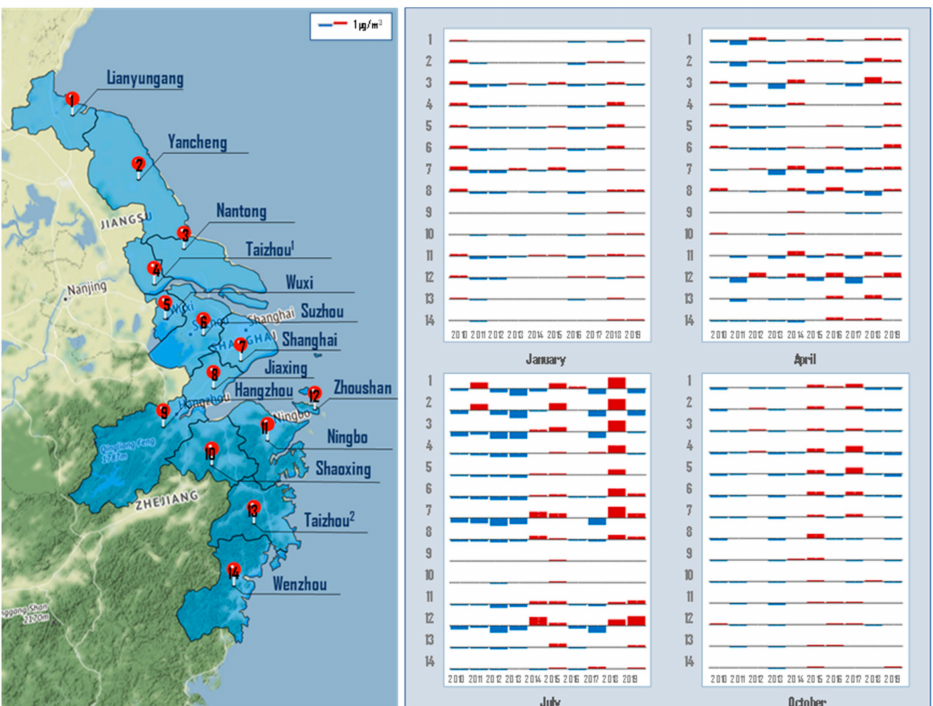
Figure 6. Anomalies of ship-contributed PM 2.5 ( µ g/m 3 ) based on the seasonal average of each year and the 10-year average in coastal cities of YRD in January, April, July and October, which represent the four seasons of winter, summer, fall and spring,